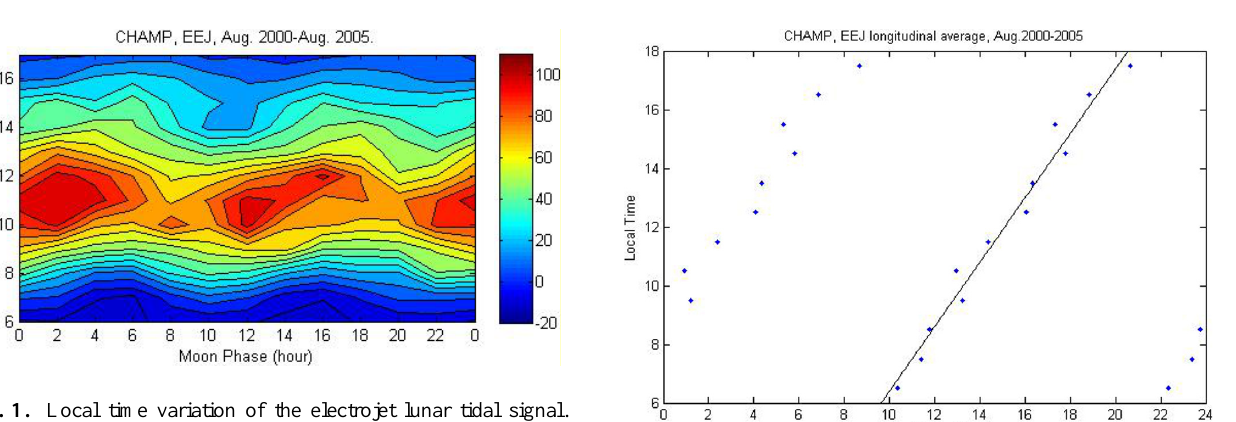
Fig. 2. Local time variation of the amplitudes from some tidal harmonics over a lunar month: (black) constant part, (blue) first harmonic, (red) second harmonic.